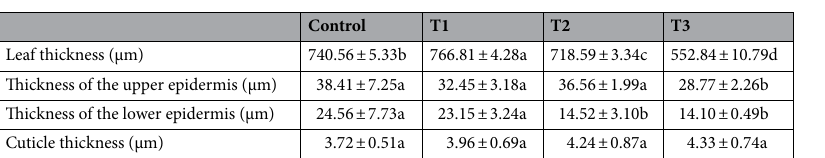
Table 4. Statistical analysis of the leaf anatomical structure of Phedimus aizoon L. under drought stress.